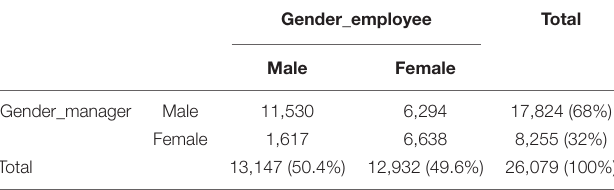
TABLE 1 | Contingency table of gender dyad (manager-employee)